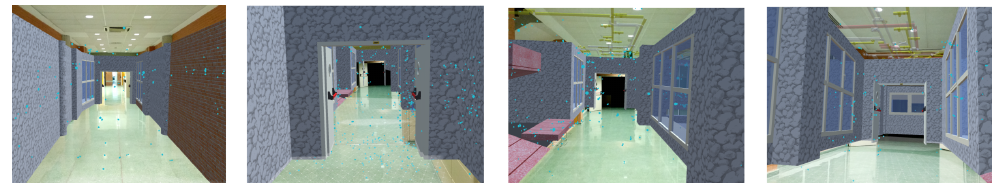
Figure 15. User navigation through a corridor of the study area.